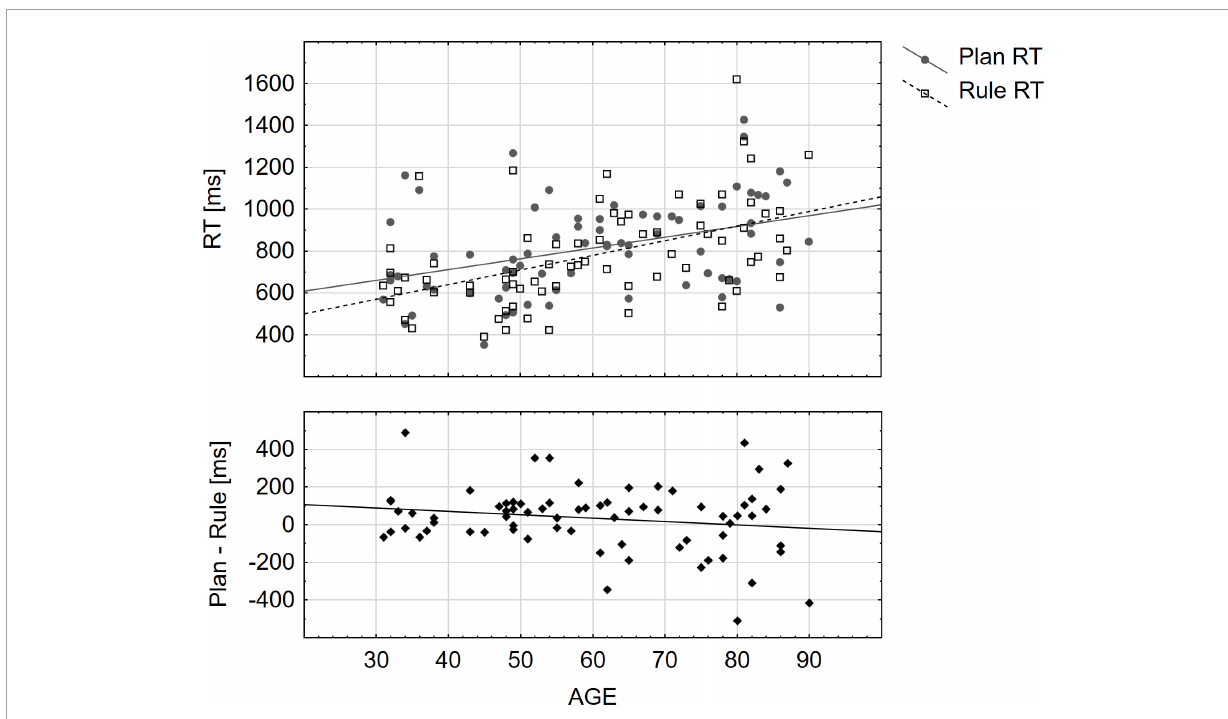
FIGURE3 The figure depicts task-specific (upper panel) and rule efficiency (lower panel) reaction time (RTs) distributions, demonstrating a change in strategy advantages with increasing age. While young participants appeared quicker in rule-based action selection, older adults varied more strongly in which approach was more advantageous. (Upper panel) Mean plan- and rule-task RT for each participant, plotted against each participant’s age in years. (Lower panel) Rule efficiency effect (mean rule-task RT subtracted from mean plan-task RT) for each participant plotted against each participant’s age. See Supplementary Figure 2 for a breakdown of the (lower panel) by hand and first task.